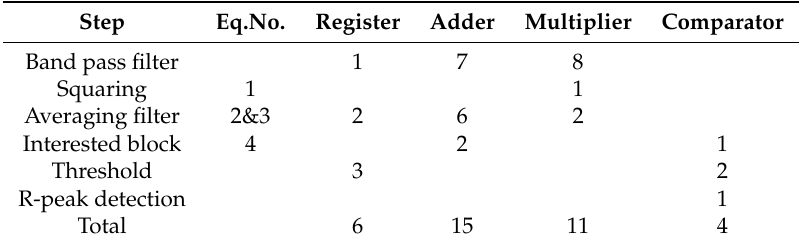
Table 2. Computational resource cost of each step in Elgendi’s algorithm.